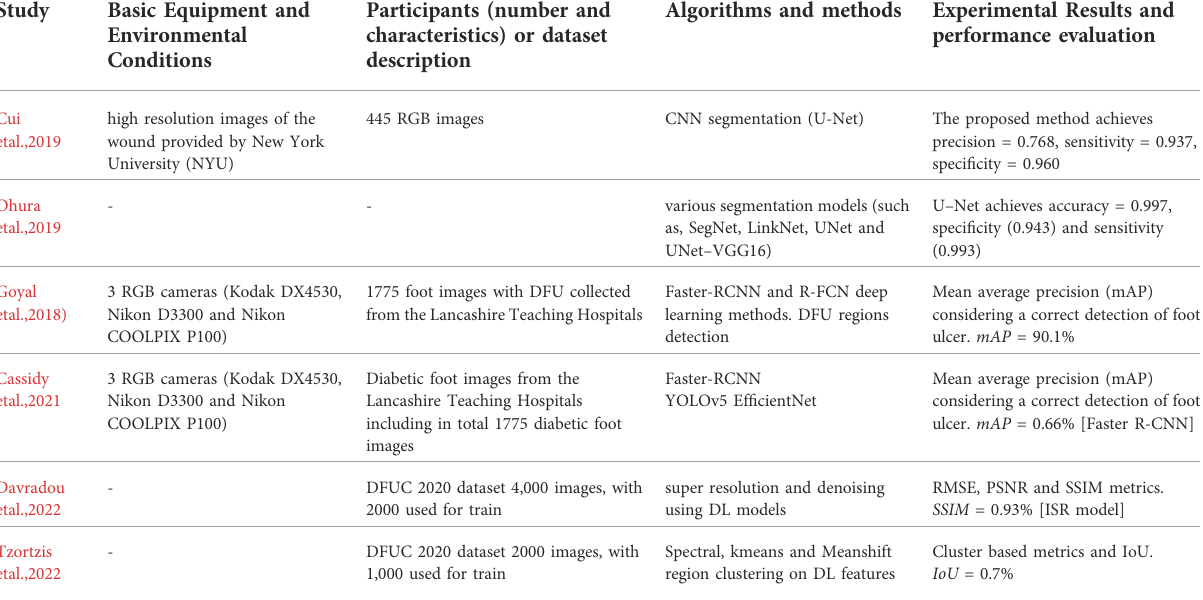
TABLE 3 Summary of the literature for diabetic foot monitoring using RGB imagery